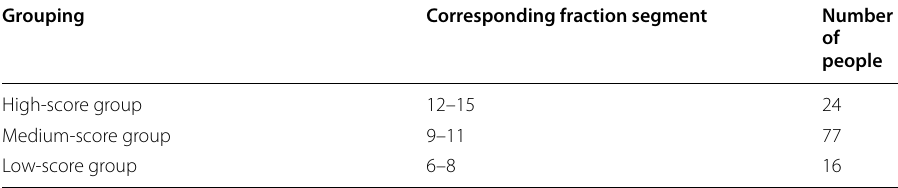
Table 6 Composition score and proportion of high, medium and low scores Grouping